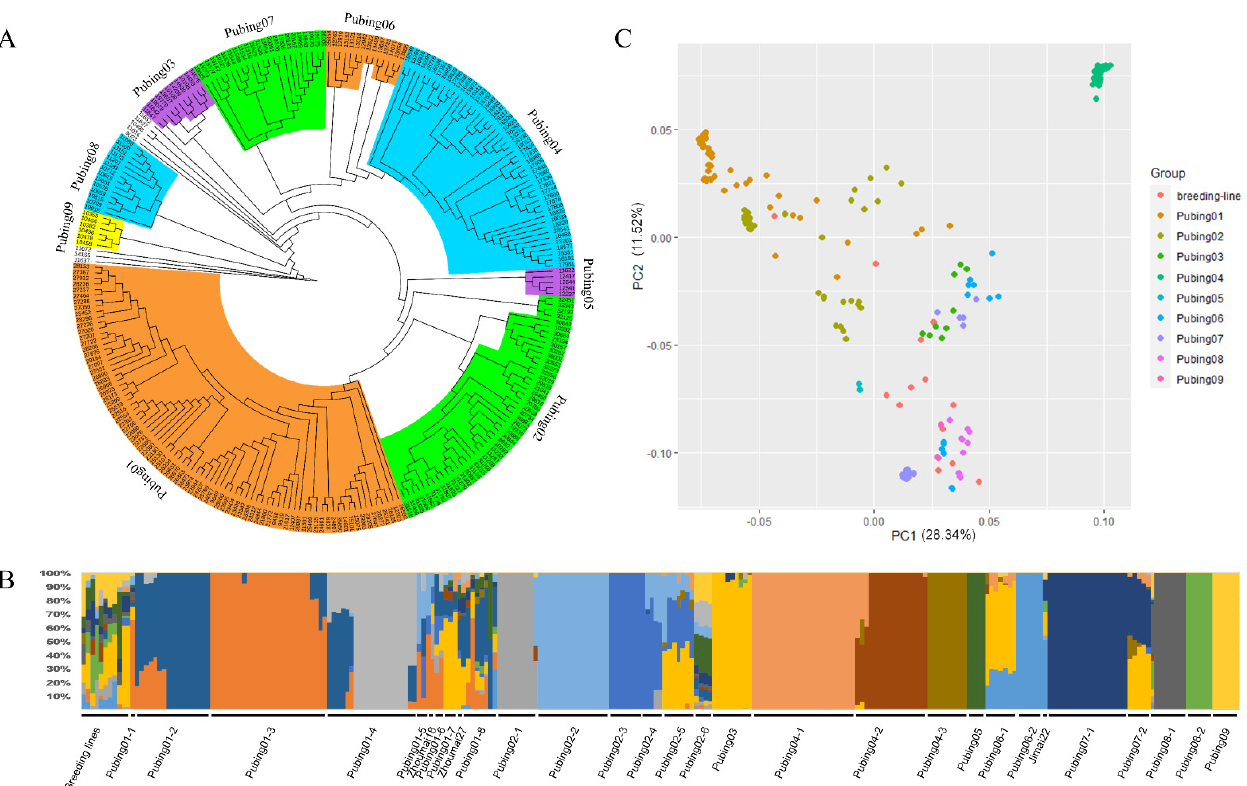
Figure 2. Genetic relationship of 255 pre-breeding lines and 4 elite commercial varieties. ( A ) Neighbor joining (NJ) phylogenetic tree construction for all lines. All accessions were divided into 10 major groups, including breeding line group and other 9 other pre-breeding line groups. ( B ) Population structure of 259 accessions. ( C ) Principal component analysis (PCA) showing the first two principal components. Dot colors correspond to the phylogenetic tree grouping.